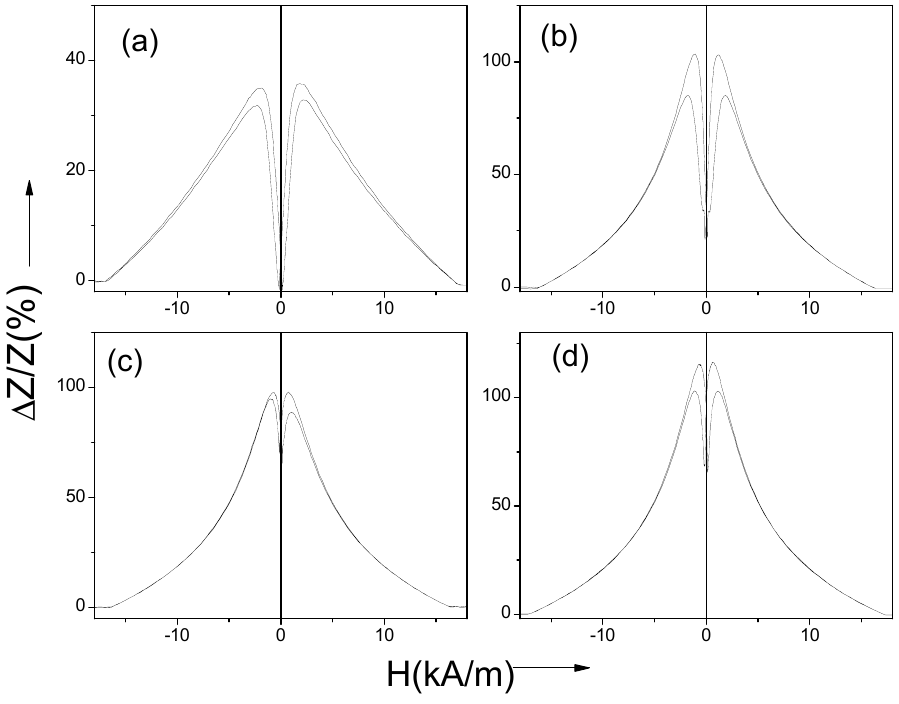
Figure 9. ∆ Z / Z(H) dependencies measured at 500 MHz, annealed at T ann = 200 ◦ C and T ann = 350 ◦ C ( a , b ) and stress-annealed at the same T ann ( c , d ) Figure 9. Δ Z/Z(H) dependencies measured at 500 MHz, annealed at T ( a , b ) and stress-annealed at the same T